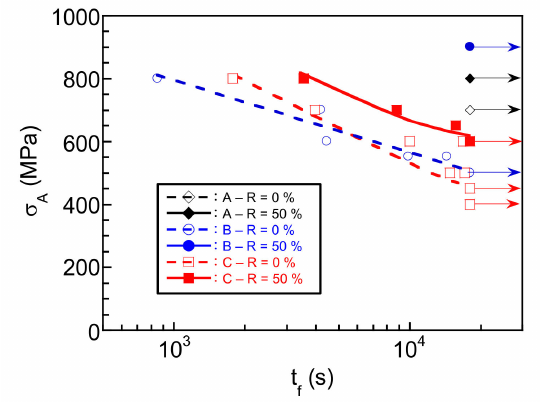
Figure 8. Applied stress–time to fracture ( σ A – t f ) curves of conventional and hot-forged steels A, B, and C. R represents reduction ratio.